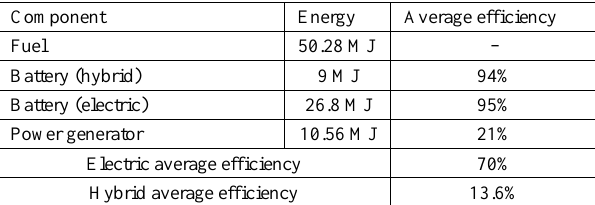
Table 2. Efficiency of power transmission